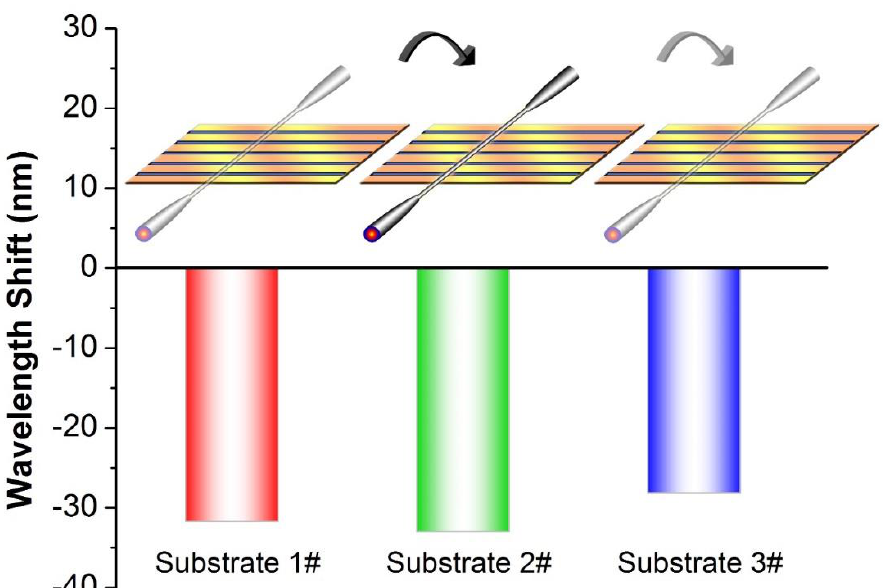
Figure 7. Response of the VIOLINs, using the substrates in a batch, with respect to 0.1 M pMBA solution. Inset: the scheme of substate-changing in the tests.